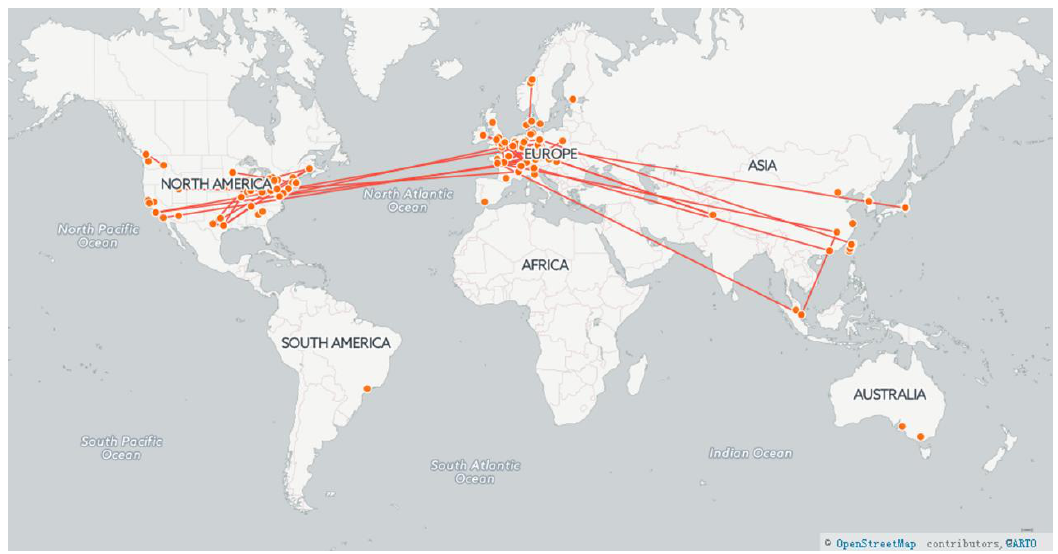
Figure 8. Geovisualization of scientific collaboration.